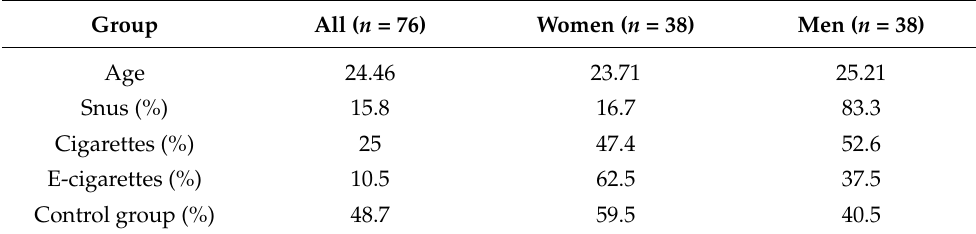
Table 1. Smoking status of participants by